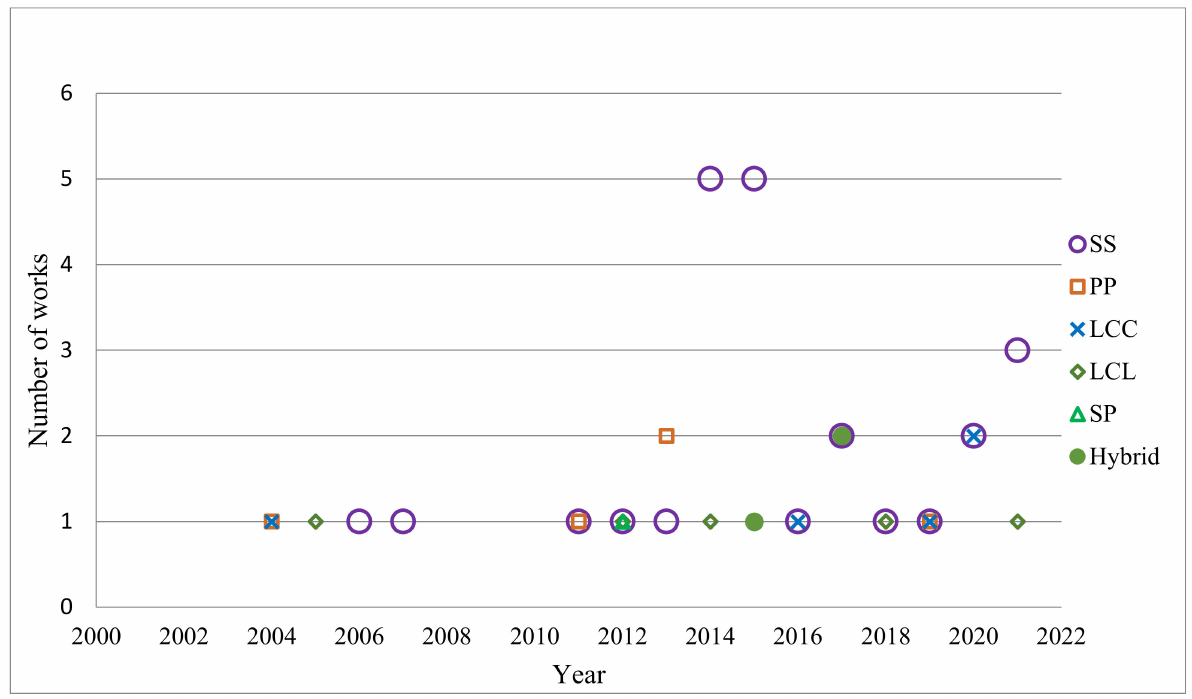
Figure 13. Number of works of compensation topologies used in academic studies by year of